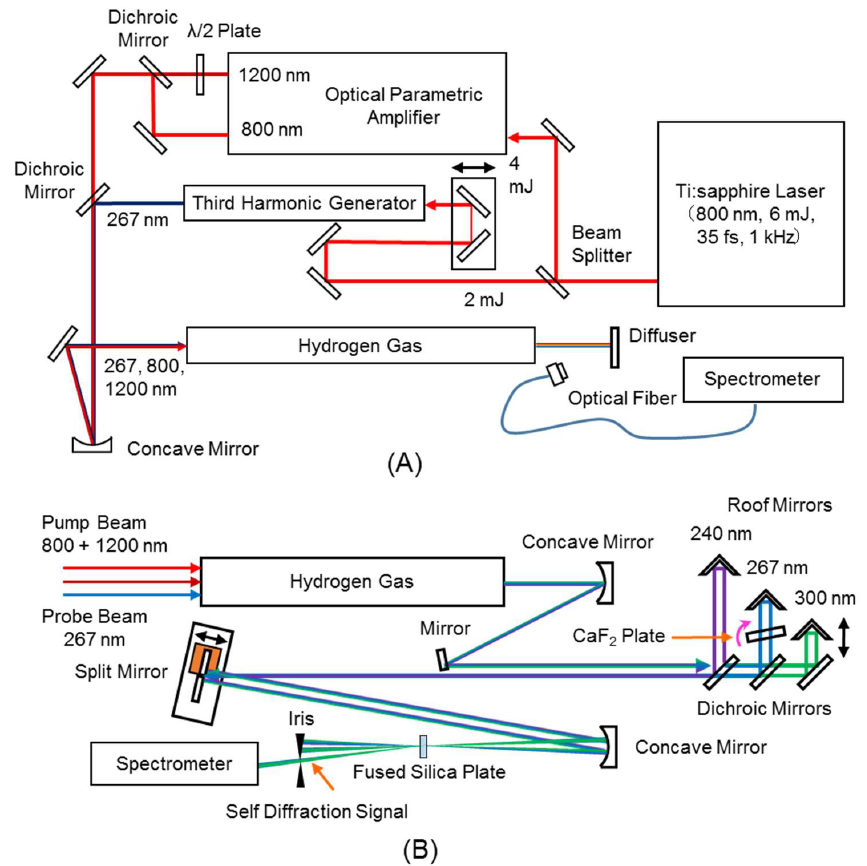
Figure 1. Experimental apparatus for ( A ) the generation and ( B ) the evaluation of Raman sidebands.